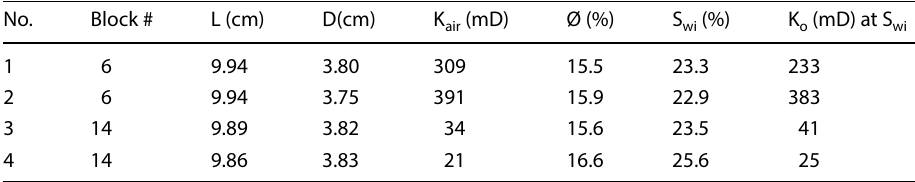
Table 5 Properties of the core